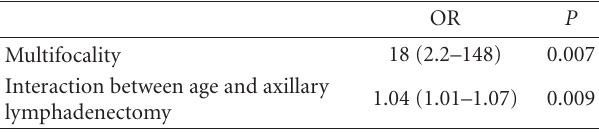
Table 3: Logistic regression: risk of complications following breast surgery performed on patients of group 1 (traditional suture